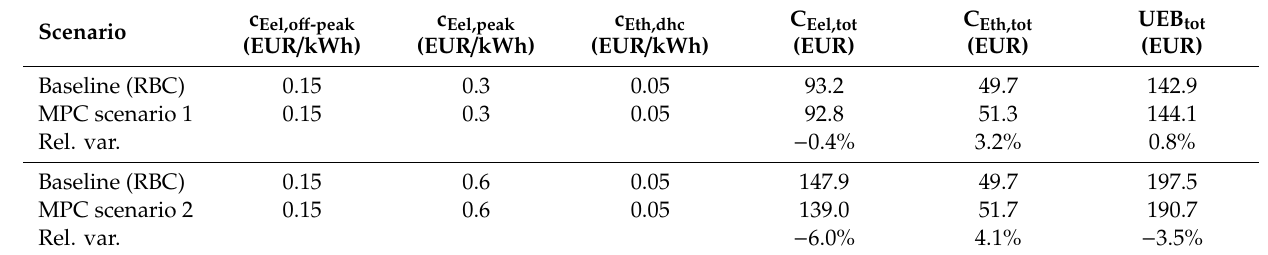
Table 3. Economic assessment of the scenario analysis. C Eel,tot : total cost for the electrical energy, C Eth,tot : total cost for the thermal energy and UEB tot : total utility energy